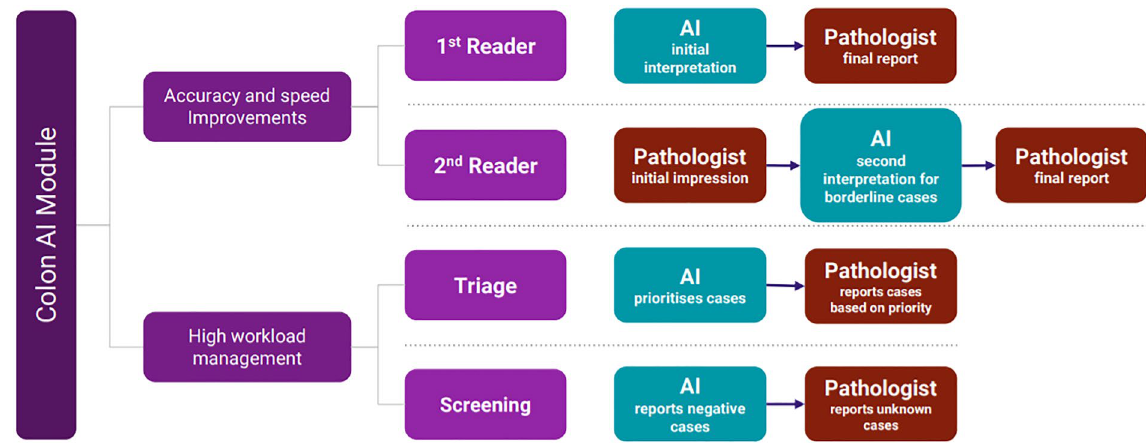
Figure 5. Proposed workflow for the use of AI in pathology.